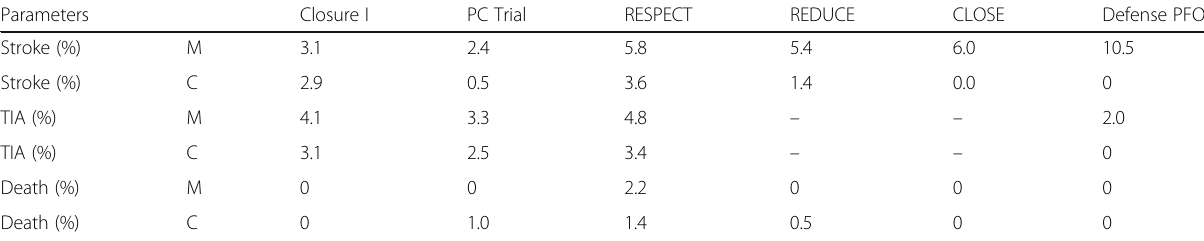
Table 2 Results from the six randomised studies on PFO closure in cryptogenic stroke (data from 10, 12, 21)